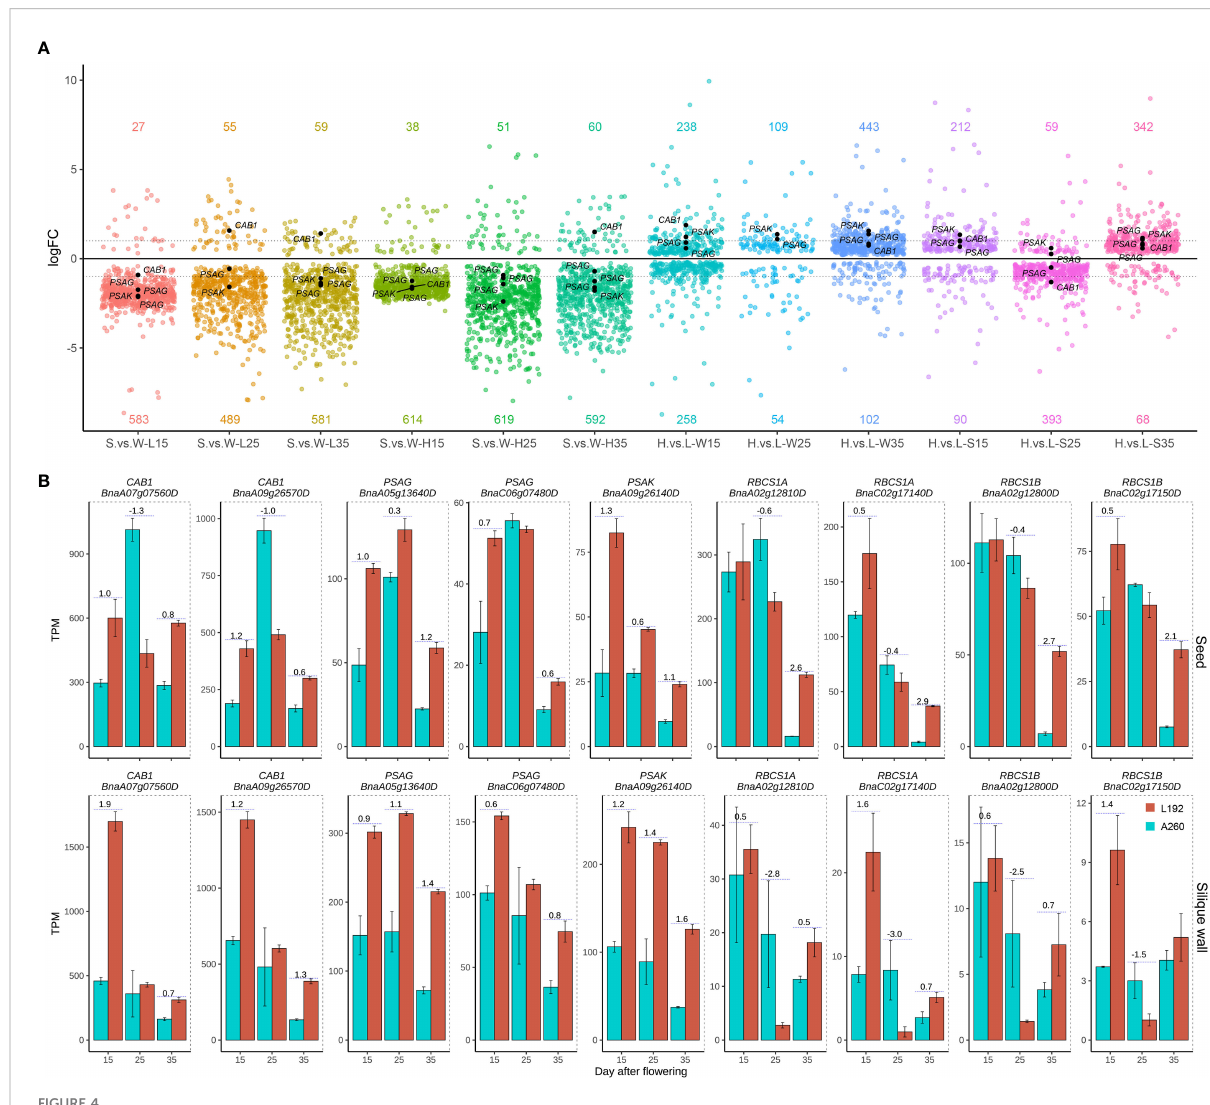
FIGURE 4 Expression difference of photosynthesis genes between the two genotypes. (A) Quantity variance of DEGs between seeds and silique walls in one genotype or DEGs of L192 versus A260 in seeds or silique walls. The number represents the number of upregulated (above the x-axis) or downregulated (below the x-axis) genes. One point represents one DEG. H, samples of L192 (high oil content). L, samples of A260 (low oil content). S, seed. W, silique wall. 15, 25 and 35, 15, 25 and 35 days after fl owering, respectively. H.vs.L-S, comparsion of L192 versus A260 in the seeds. H.vs.L-W, comparsion of L192 versus A260 in the silique walls. S.vs.W-L, comparsion of seeds versus silique walls of A260. S.vs.W-H, comparsion of seeds versus silique walls of L192. (B) Expression pro fi les of some photosynthesis related genes. The bars represent the means of three biological replicates (TPM value), error bars are the standard deviation, and the numbers on the bars are the logFC (FC, fold change, comparison of L192 versus A260). CAB , Chlorophyll A/B binding protein; PSAK , Photosystem I subunit K; PSAG , Photosystem I subunit G; RBCS1A , Rubisco small subunit 1A; RBCS1B , Rubisco small subunit